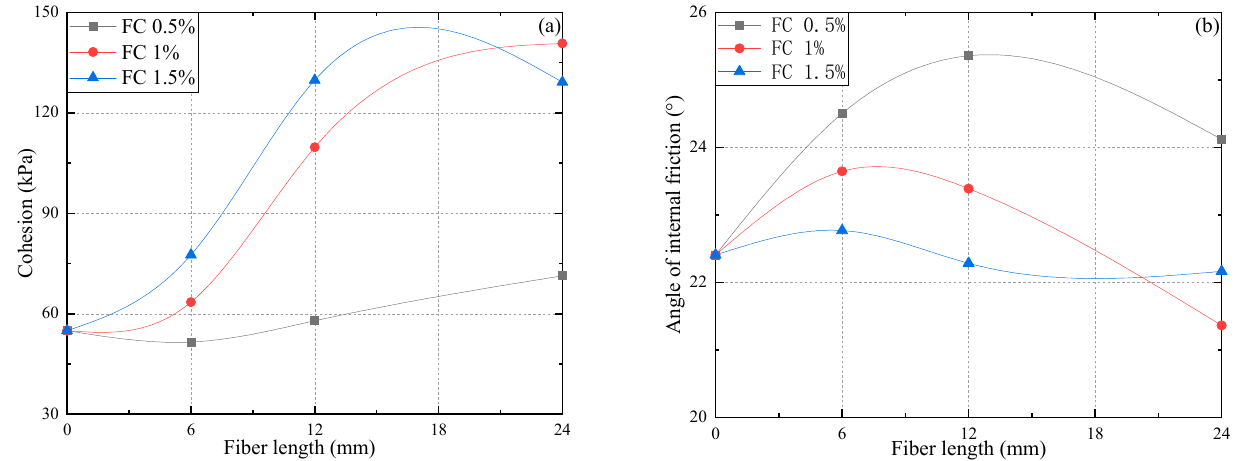
Figure 13. Shear strength parameters of reinforced specimens against various FL and FC, ( a ) cohesion, and ( b ) angle of internal friction.